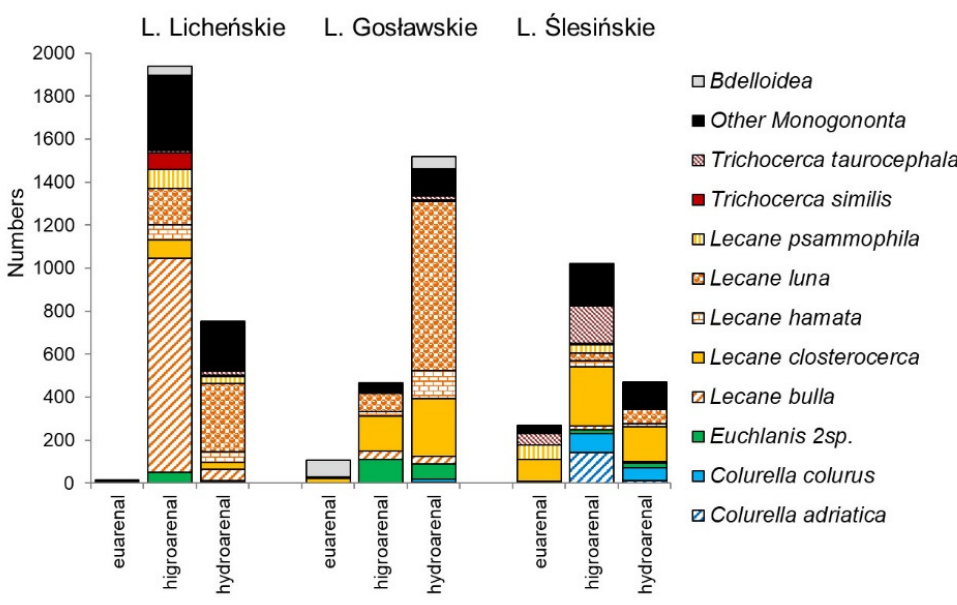
Figure 8. Densities (ind. 100 cm 2 ) of rotifer species dominating in psammon communities in three zones of lake arenal in the Konin lakes.